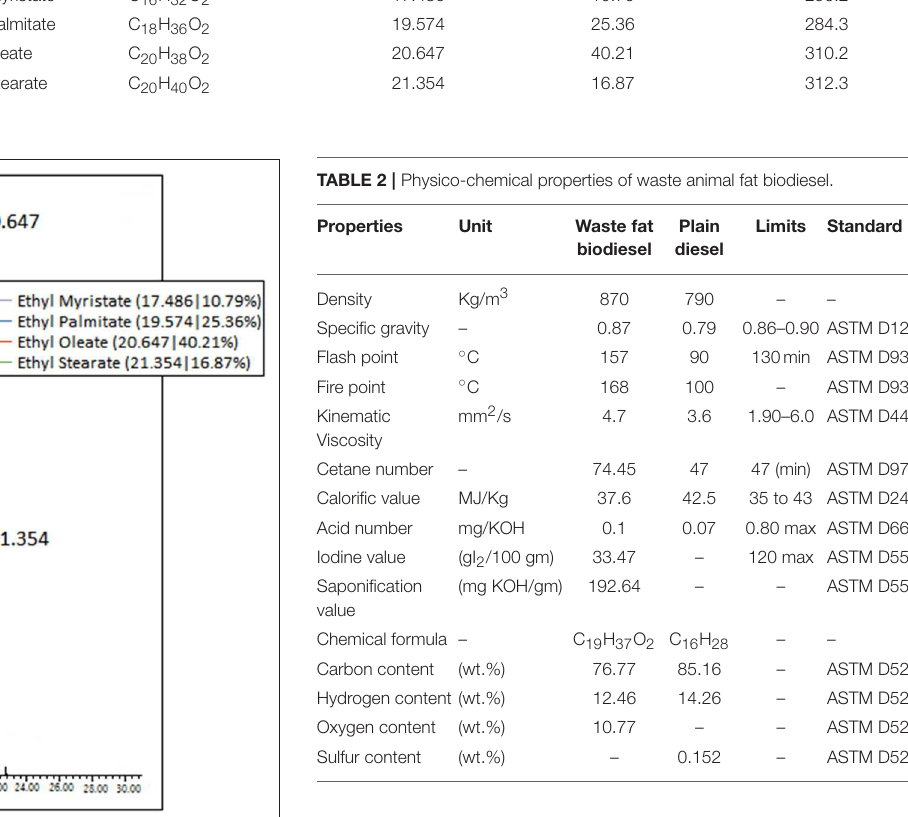
Table 3 outlines the technical specifications of Kirloskar